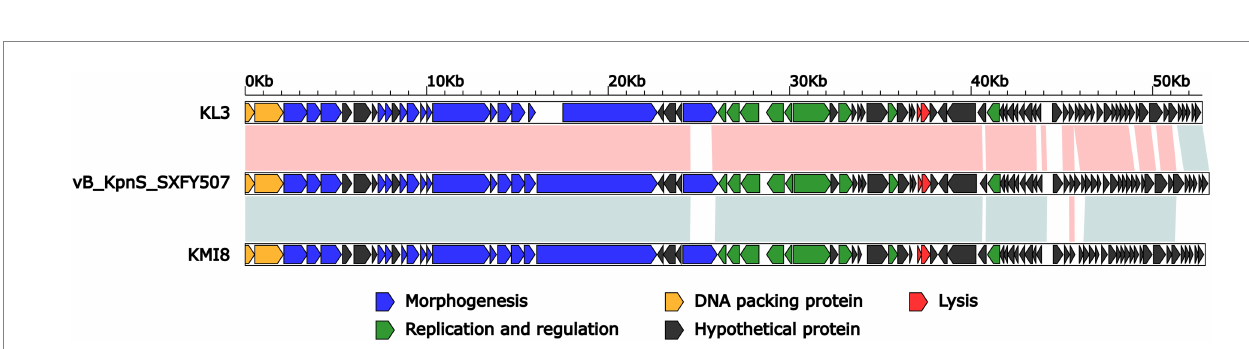
ORF25 were head morphogenesis protein, major capsid protein, tail